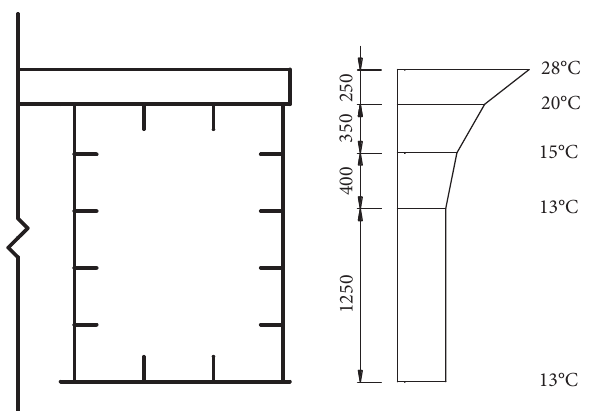
Figure 12: The vertical temperature gradient of the main